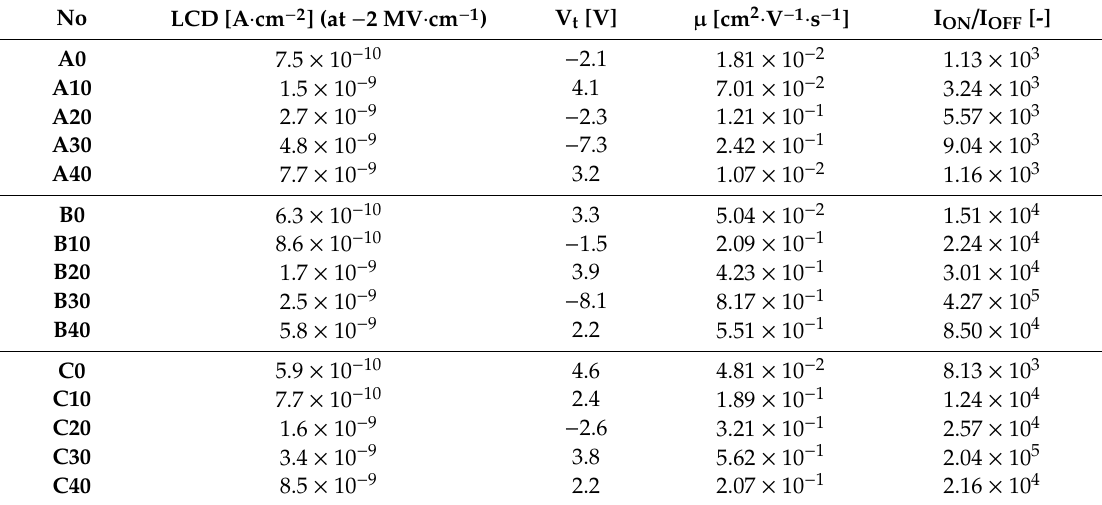
Table 3. The electrical data of OTFTs fabricated by various hybrid